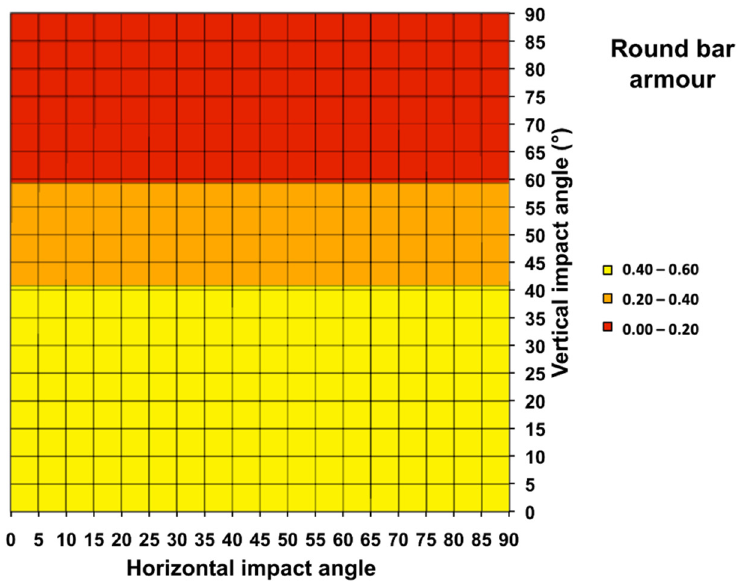
Figure 20. Efficiency of a steel round bar cage armour solution as a function of the horizontal and vertical impact angle.